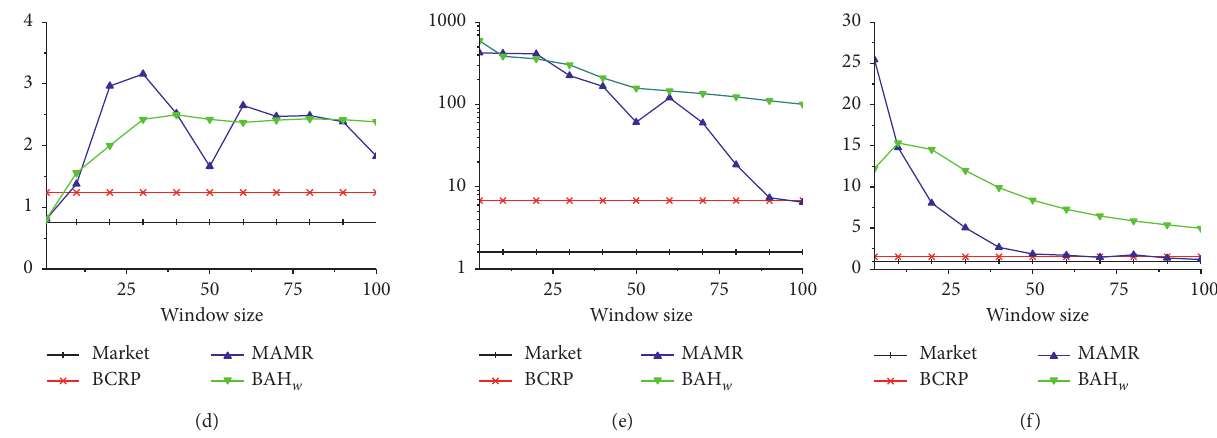
Figure 3: Parameter sensitivity of MAMR with respect to w with fixed ε � 10, C (d) DJIA. (e) TSE. (f)